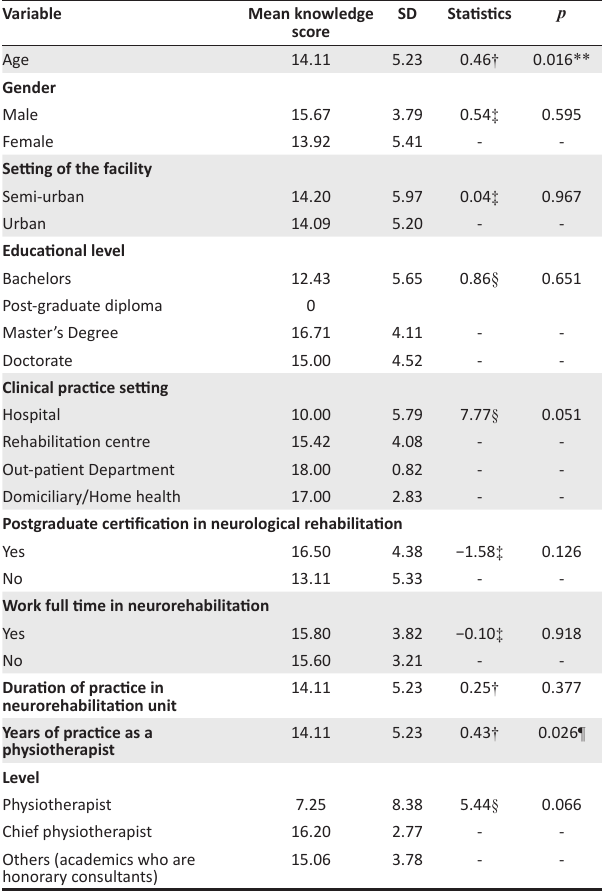
TABLE 3: Relationship between physiotherapists’ unilateral spatial neglect knowledge demographics.